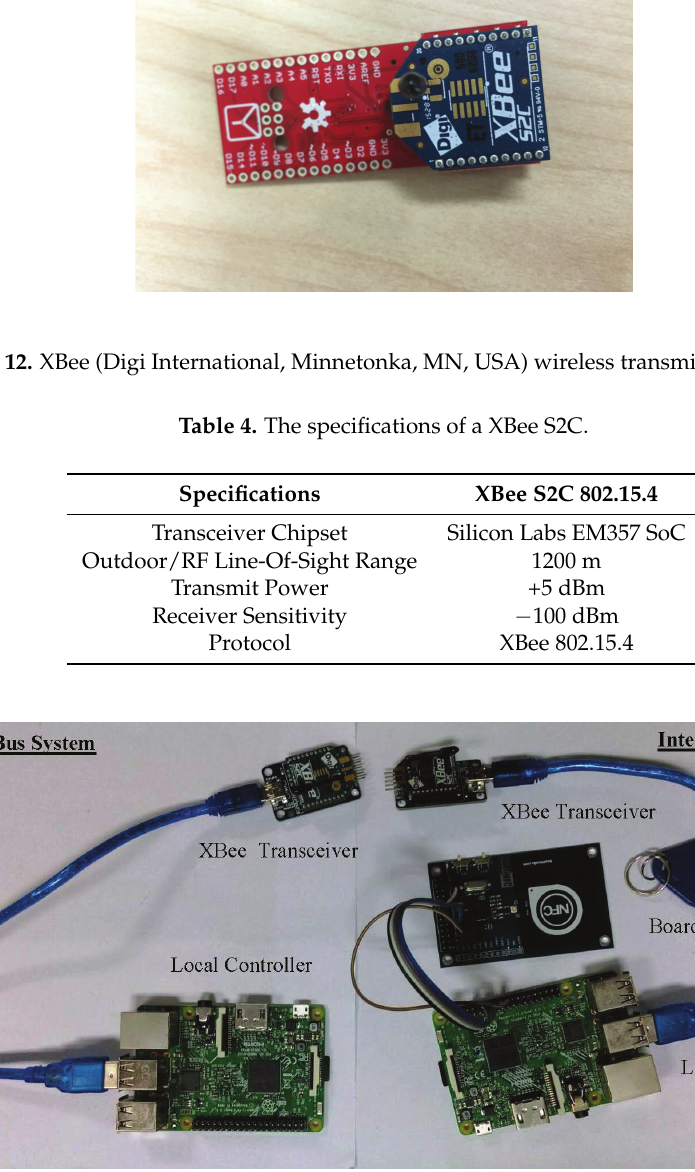
Figure 13. A prototype of wireless bus management system: a bus system (consisting of an XBee transceiver and a local controller) ( left ) and an interactive bus stop (consisting of a XBee transceiver, a boarding request reader and a local controller) ( right